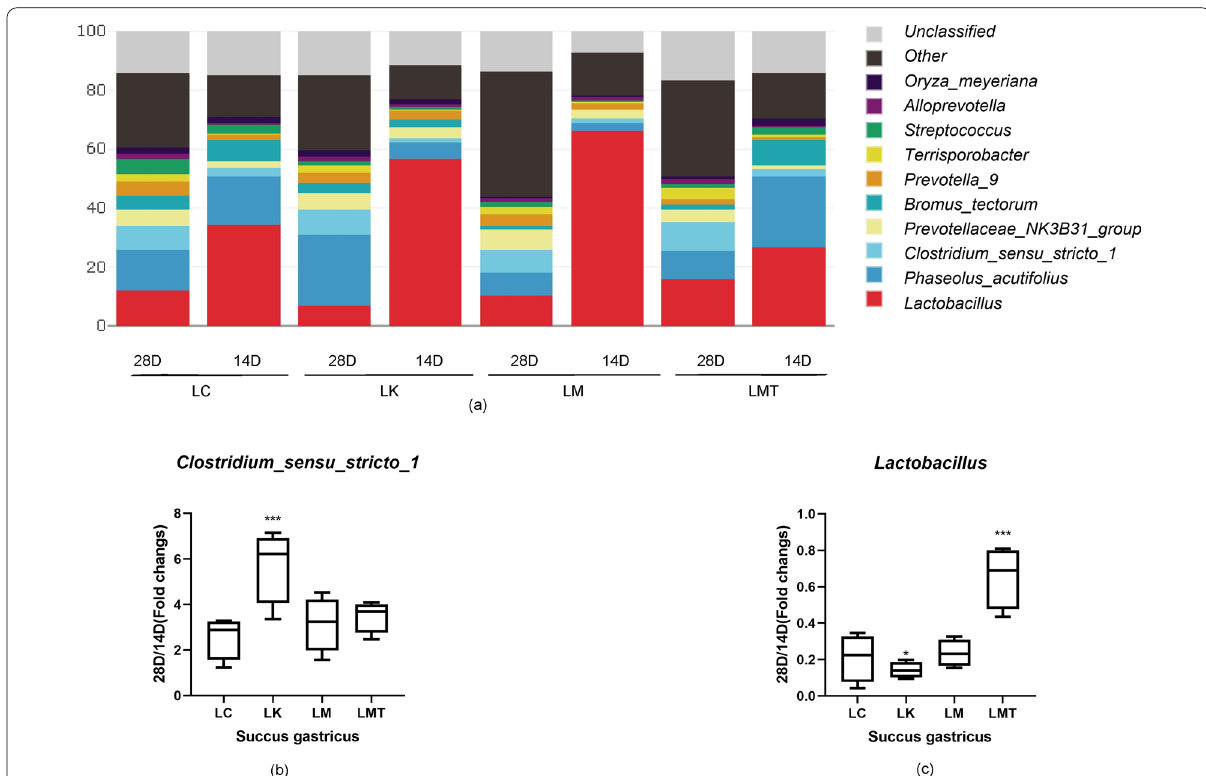
Fig. 8 The composition of the succus gastricus microbiota at the genus level. a The effect of the TCM formula on the composition of the succus gastricus microbiota at the genus level in the weaned piglets. b The fold change in the relative abundance of the genus Clostridium sensu stricto 1 (28 d/14 d ratio). c The fold change in the abundance of the genus Lactobacillus (28 d/14 d ratio) ( *p < 0.05; **p < 0.02; ***p < 0.01